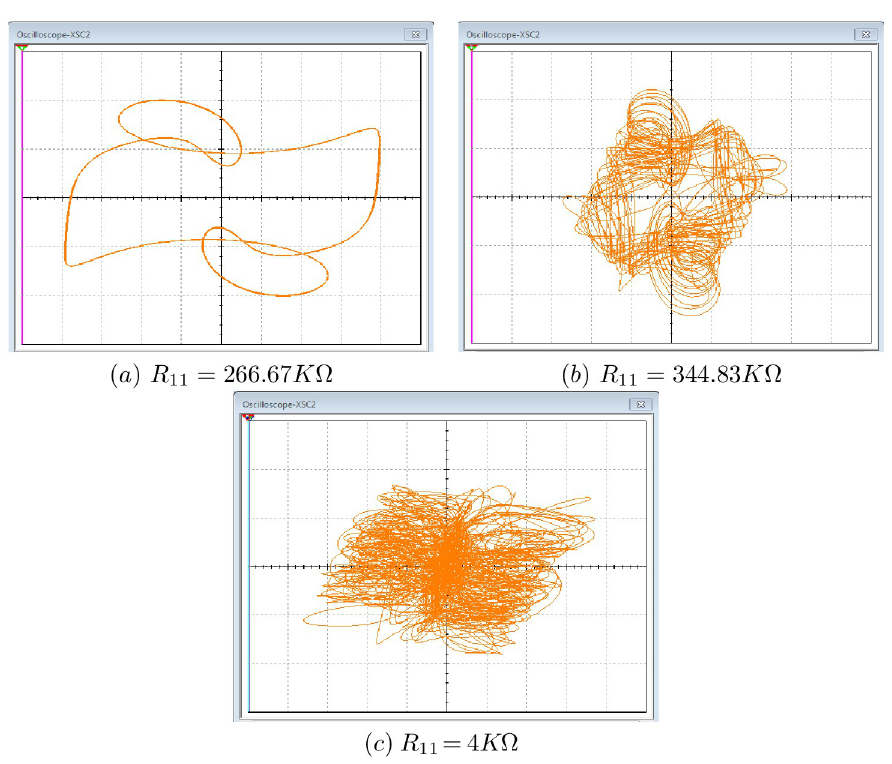
Fig 22. Experimental phase portraits of the system (1) x 3 − x 4 plane. (a): Periodic orbit, (b): Chaotic attractor and (c): Hyperchaotic attractor.